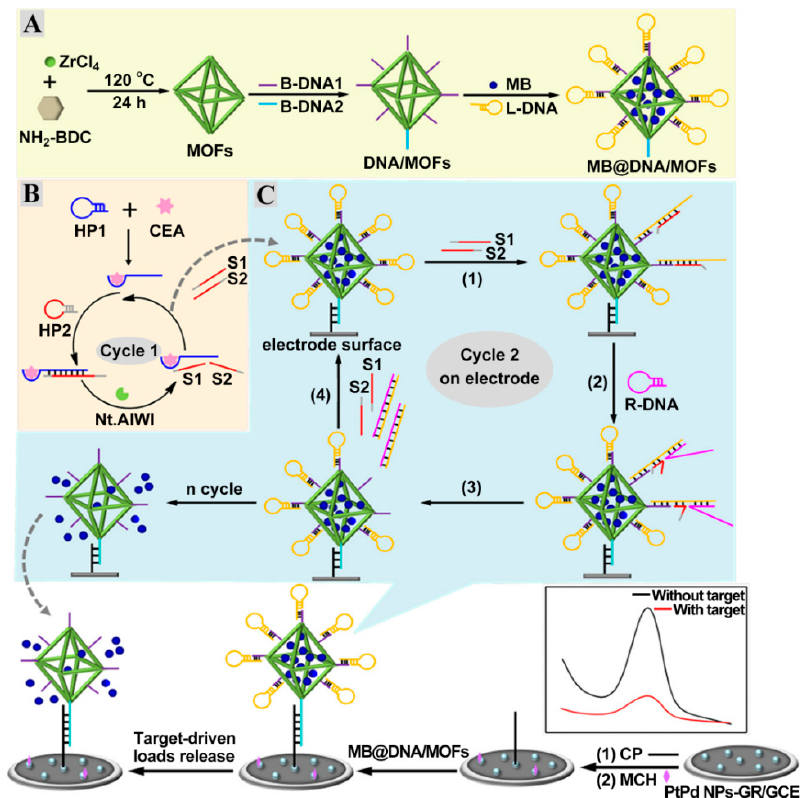
Figure 5. Scheme diagram of the DNA-gated MOF-based electrochemical biosensing platform of CEA. ( A ) Assembly procedure of MB@DNA/MOFs. ( B ) Target-triggered nicking endonuclease cleavage process. ( C ) Signal molecule release from MB@DNA/MOFs on the electrode. Reprinted with permission from ref. [74]. Copyright 2020 American Chemical